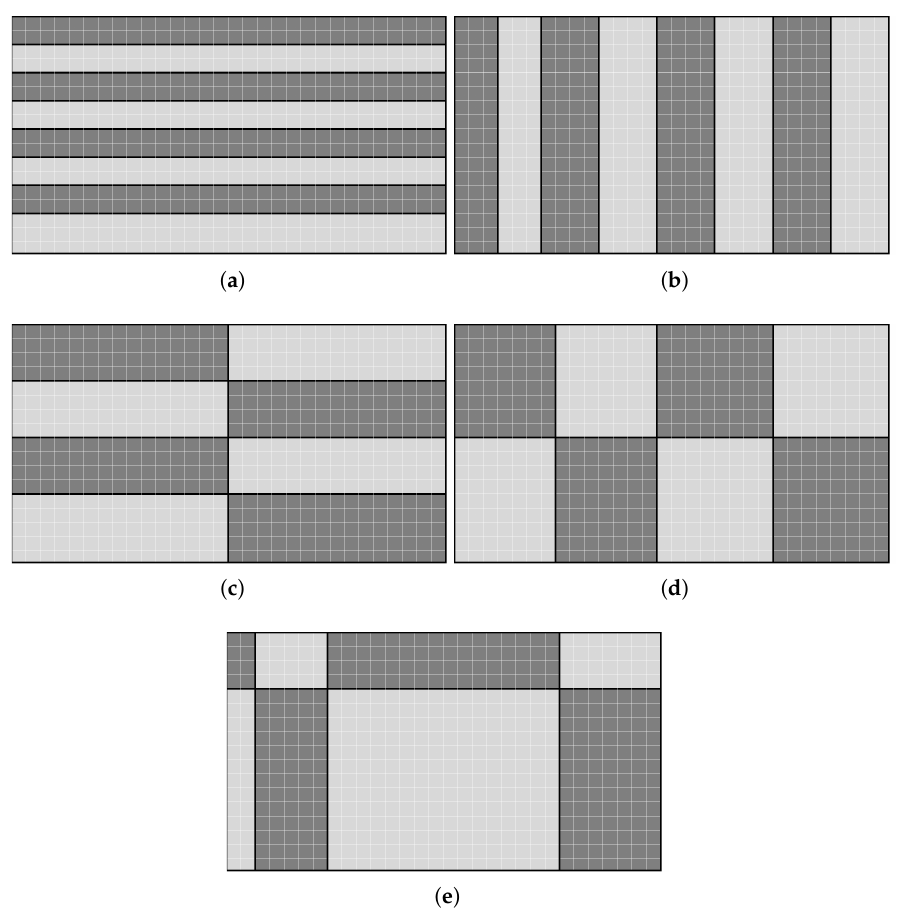
Figure 4. Five different tile layouts (4 homogeneous + 1 heterogeneous) for the partitioning of a Full